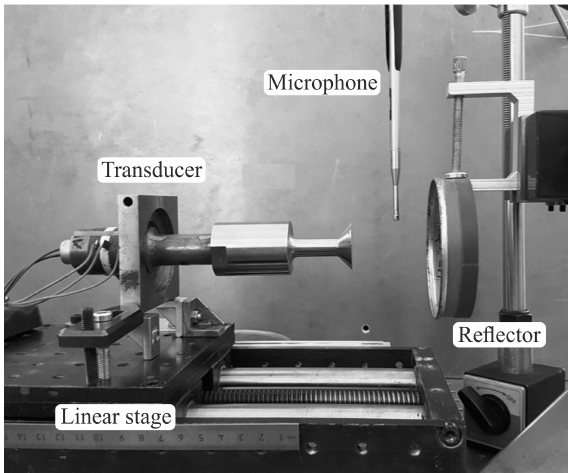
Figure 11. Experimental setup of the ultrasonic standing wave system with concave reflector and